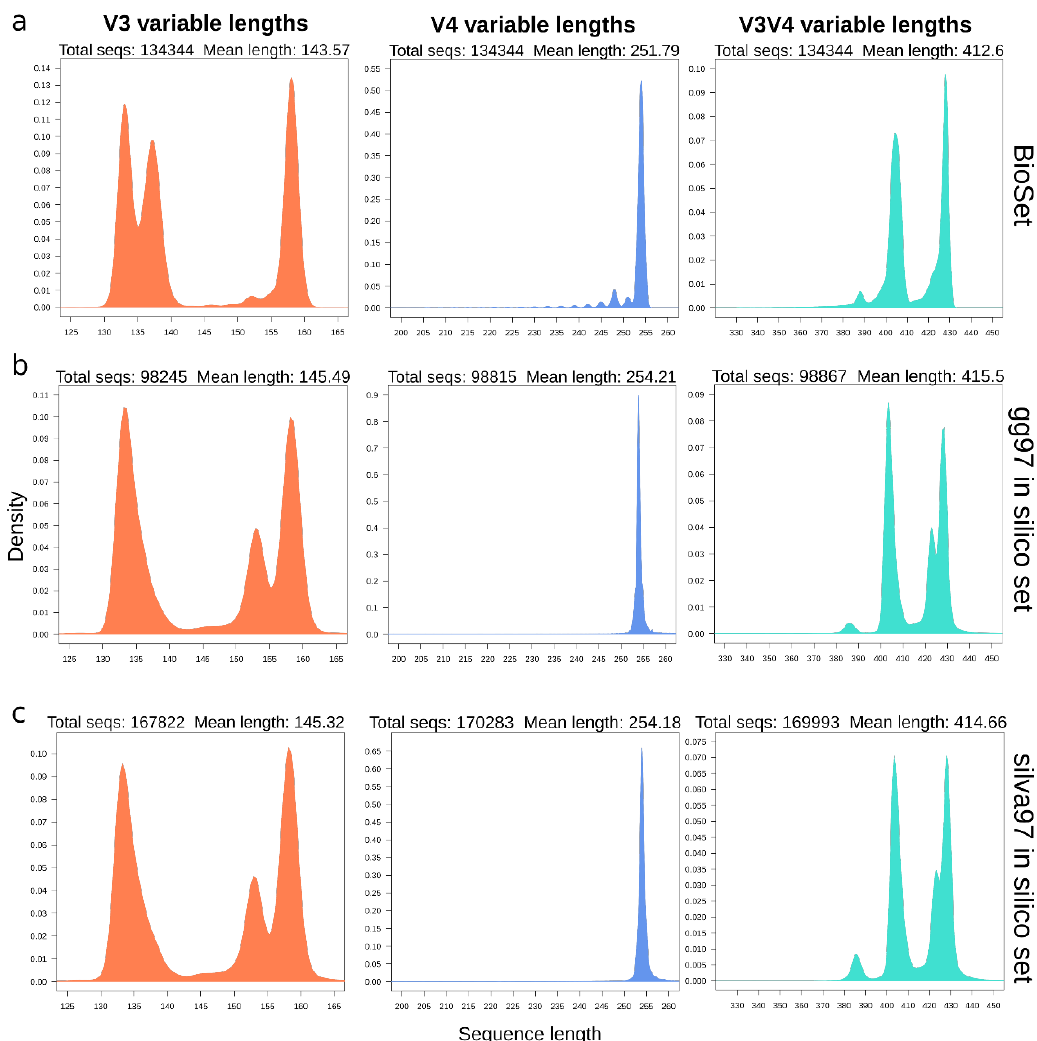
Figure 1. Sequence length distribution for V3 (left), V4 (center), V3V4 (right) experimental and in silico amplicons. ( a ) Experimental amplicons of Biological set. ( b ) Simulated amplicons constructed from the GreenGenes 97% identity clusters. ( c ) Simulated amplicons constructed from the silva 97% identity clusters.